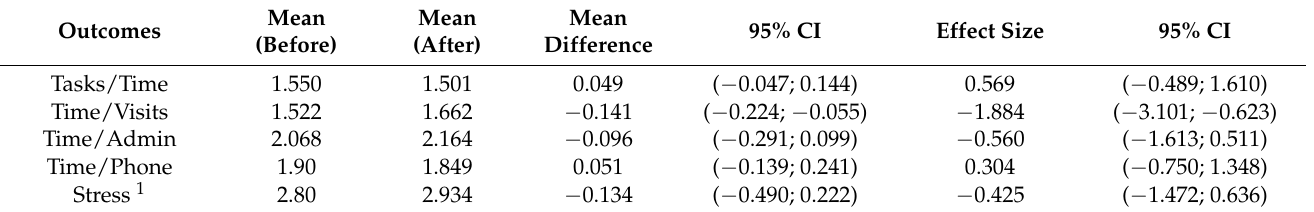
Table 4. Linear regression model, changes in outcome measures (before and after the intervention). A negative mean difference indicates increased